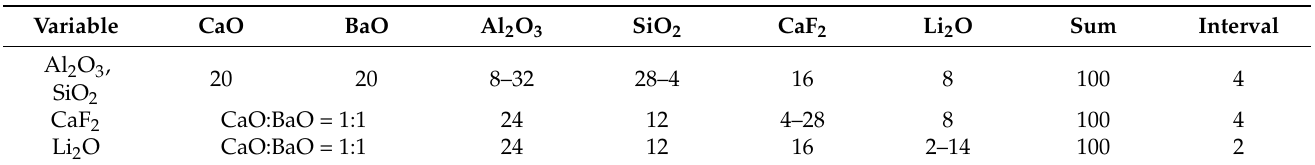
Table 6. Composition of various flux systems for investigating the effect of components on the activities of Al 2 O 3 and SiO 2 (wt%).